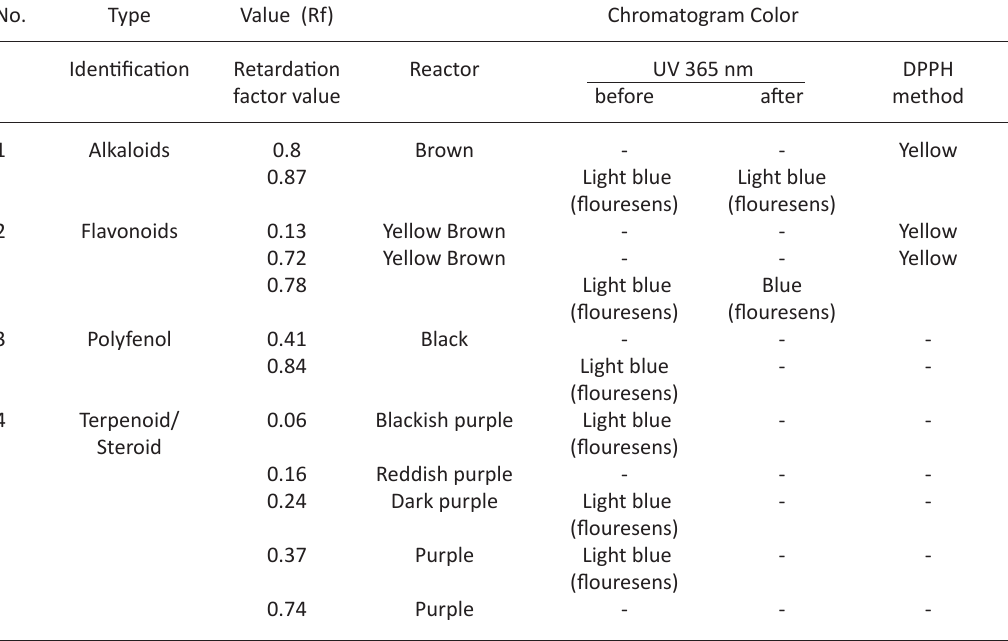
Table 7. Secondary Metabolite Screening Results of Bacillus sp . with thin-layer chromatography 12